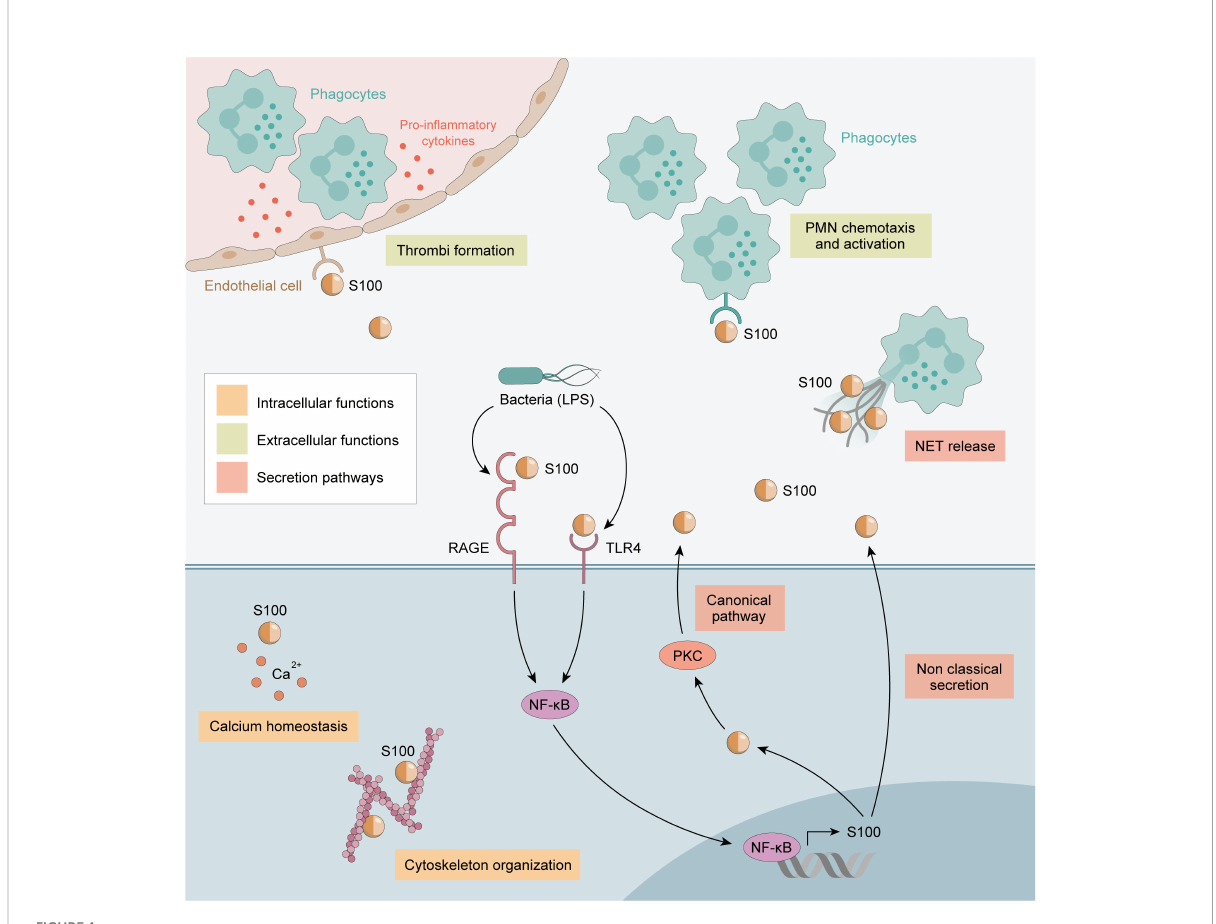
FIGURE 1 Calprotectin Functions. Intracellular functions are shown in orange and extracellular functions in green. Calprotectin Intracellular functions includes cytoskeleton cell migration and calcium homeostasis. Extracellular functions involve endothelial cells activation, promoting the adhesion of phagocytes to the vascular endothelium and thrombi formation. Also increase chemotaxis and the activation of PMN. Finally, calprotectin exerts a strong antimicrobial action against a variety of bacterial and fungal